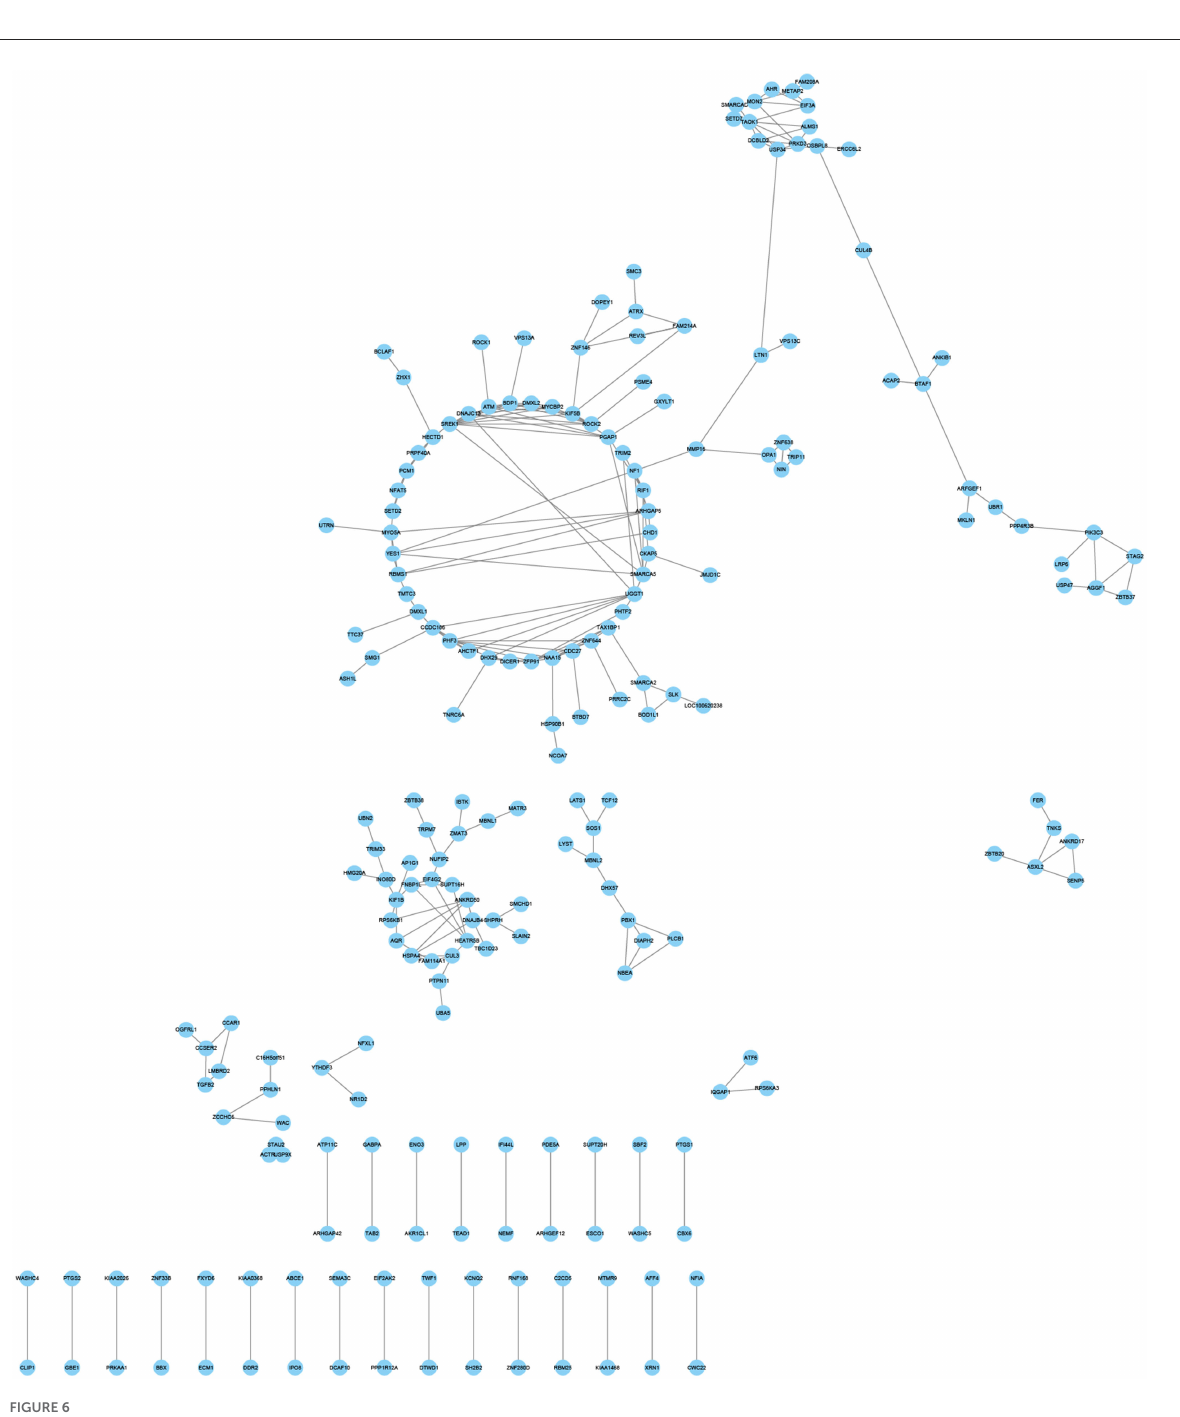
by a hypoxia condition (44). SE may be the primary source of proteomic and transcriptomic and plays a significant role in hypoxia response by regulating genes and determining phenotype as the most abundant event types (73.01%) in ATII cells among four groups (45,